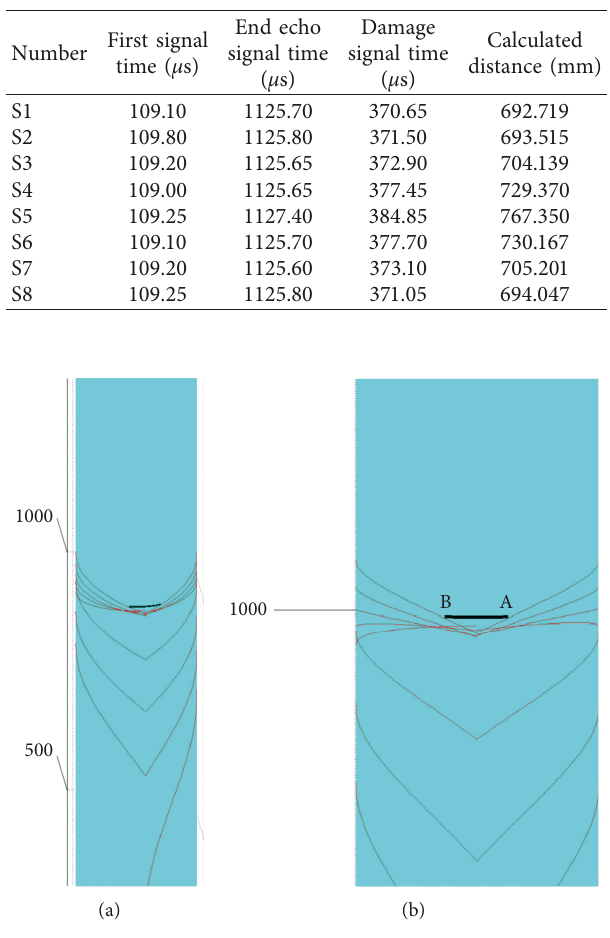
Figure 32: Single segment damage imaging: (a) partial display and (b) detail